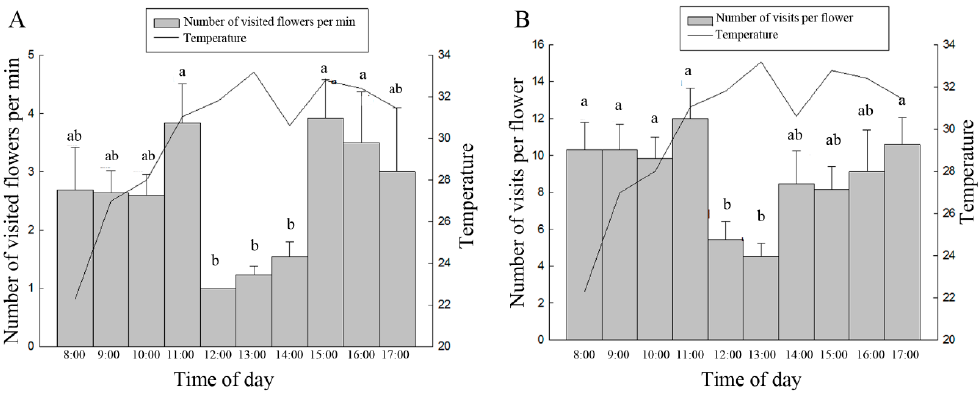
Figure 4. Collecting behavior of A. mellifera on the oil tree peony ‘Feng Dan’ in different time periods. ( A ) Number of flowers visited by A. mellifera ; ( B ) number of A. mellifera visits to oil tree peony flowers. Notes: The data in the figure are presented as the mean ± standard error, and different letters above